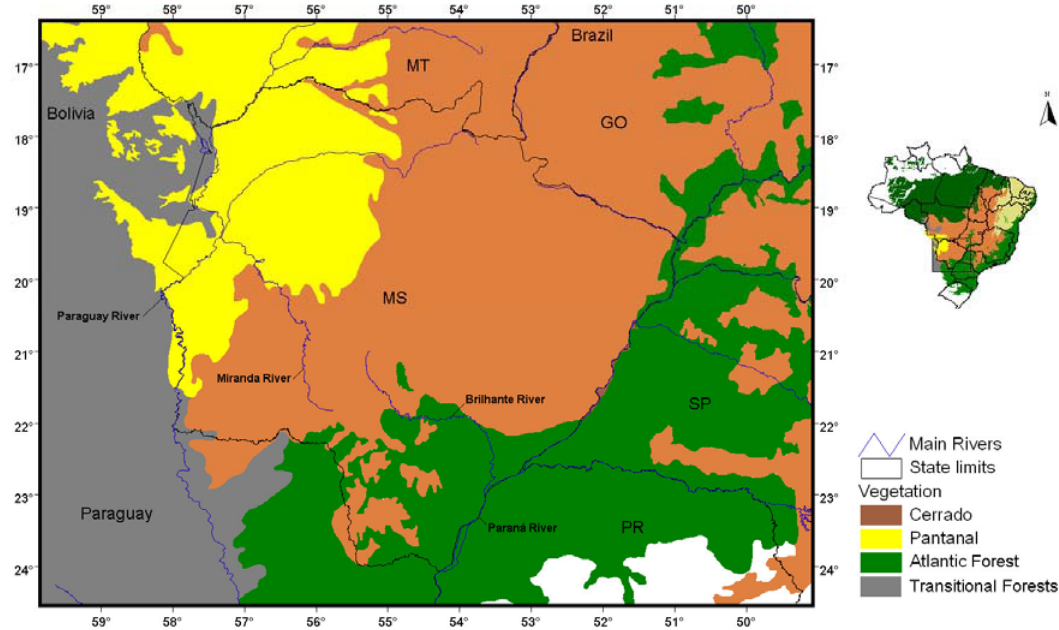
Figure 1 . State of Mato Grosso do Sul (MS) showing the main rivers that cross the state and the vegetation domains according to IBGE (1992). This area is located in the south-western Brazil, as showed in the inserted map on the right side of the figure. Transitional forests correspond to a complex region that includes Amazon forest and Chaco